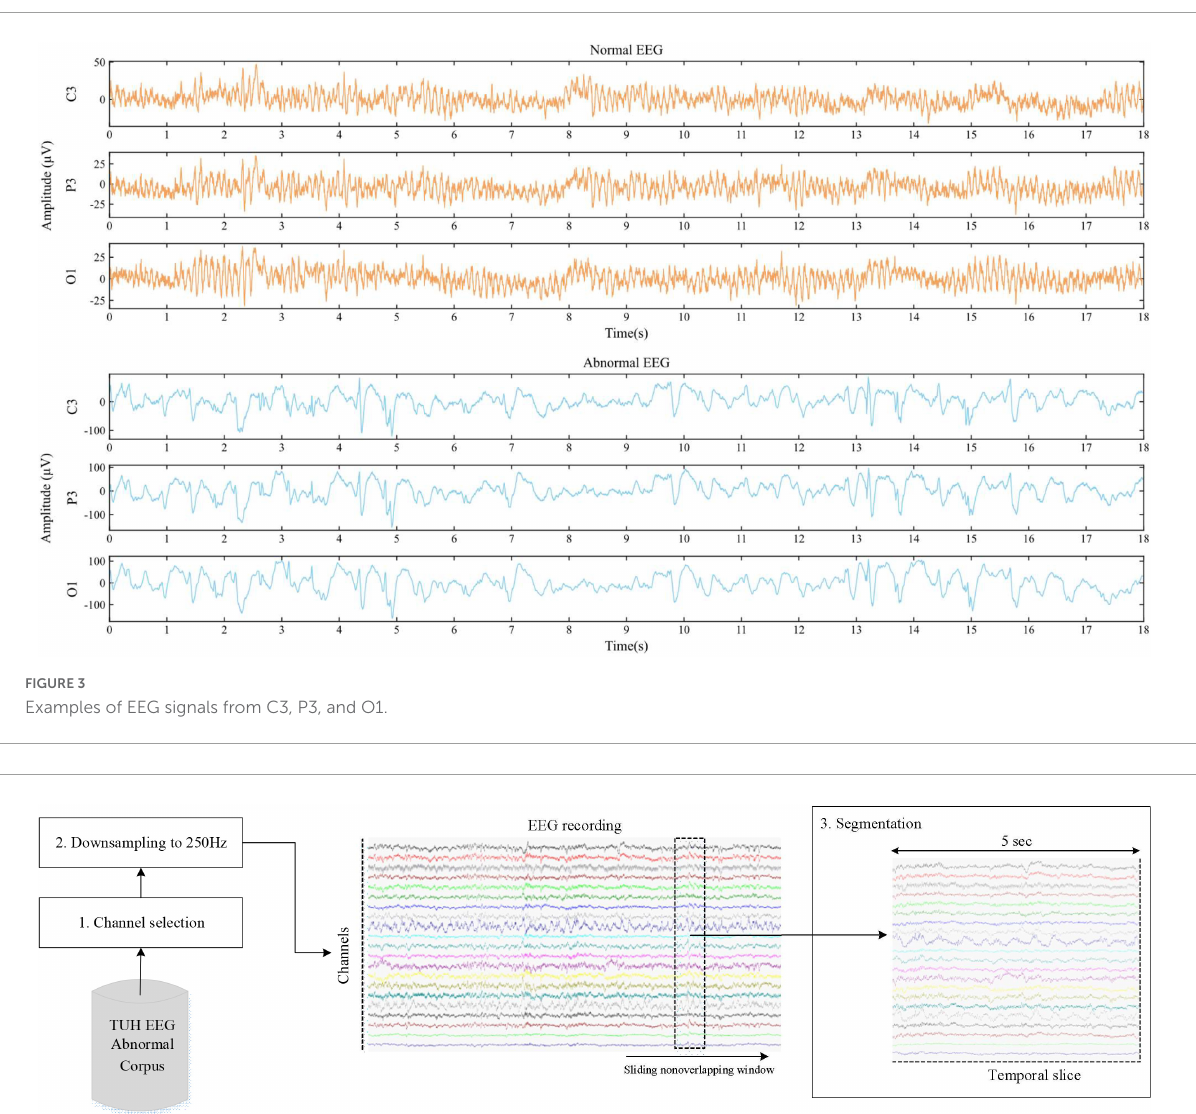
FIGURE4 The flows of EEG